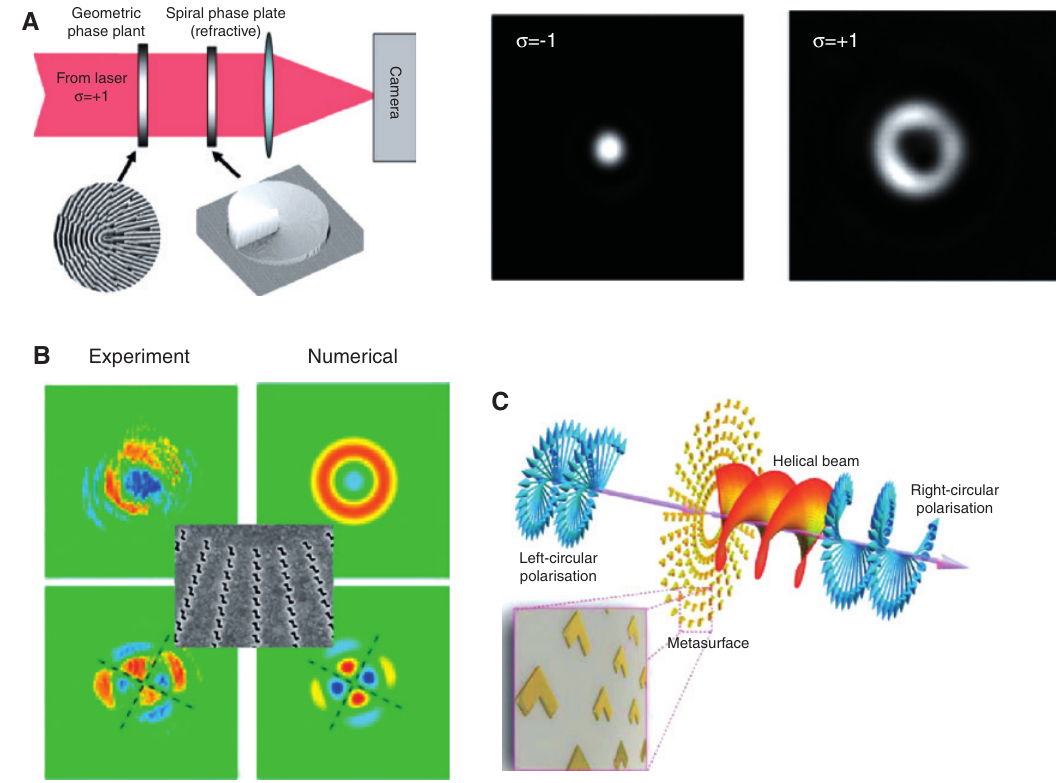
Figure 4: Spin splitting in angular momentum space. (A) Measuring an l = ± 1 vortex beam from a diffraction q -plate using a spiral wave plate. Measured intensity distributions are shown on the right. Reproduced from Ref. [75]. (B) Metasurface for spin-induced manipulation of OAM. Measured (left column) and numerical (right column) Stokes parameter S with RCP incident light (top row) and linear polarized incident light (bottom row). Inset: SEM image of 3 metasurface sample. Reprinted from Ref. [76]. (C) Vortex beam generator using spin-to-orbit coupling through a metasurface. Reprinted from Ref.